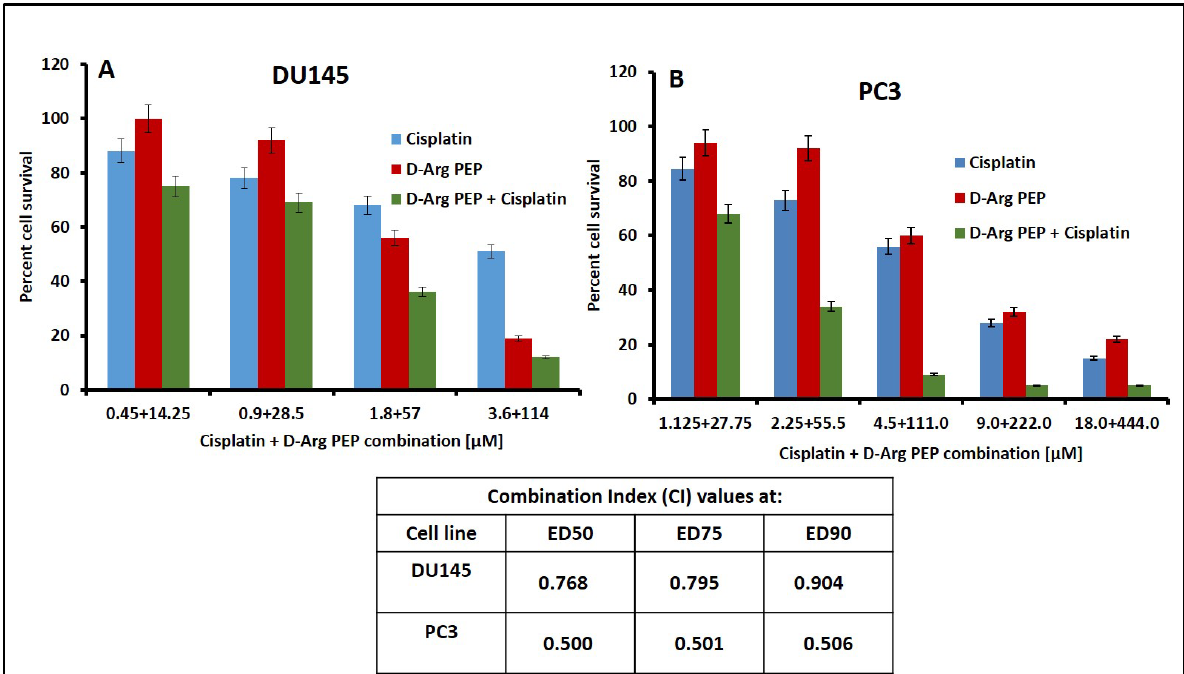
Figure 2. D-Arg PEP shows synergistic cell kill in combination with cisplatin in the prostate cancer cell lines DU145 ( A ) and PC-3 ( B ). Cisplatin and D-Arg PEP concentrations used for combination plates are shown on x axis and the percent cell survival (compared to untreated control) is shown on y axis. These drugs were added in combination at constant ratio as per 50% inhibitory concentration (IC 50 ) value for individual drugs. The given concentration was also added as a single drug in individual plates. The combination index (CI) values obtained by Chou–Talalay analysis are tabulated below the figure. The D-Arg PEP in combination with cisplatin against breast cancer cell lines (MCF7, MDA-MB-468 and 4T1) and the lymphoma cell, CCRF-CEM also showed a modest syner- gistic anti-cancer effect (Figure 3A–D, Figure S2), when treated with D-Arg PEP and cis- platin. The γ -H2AX signal as a sensitive molecular marker for DNA damage after combi- nation treatment is shown in Figure 4.